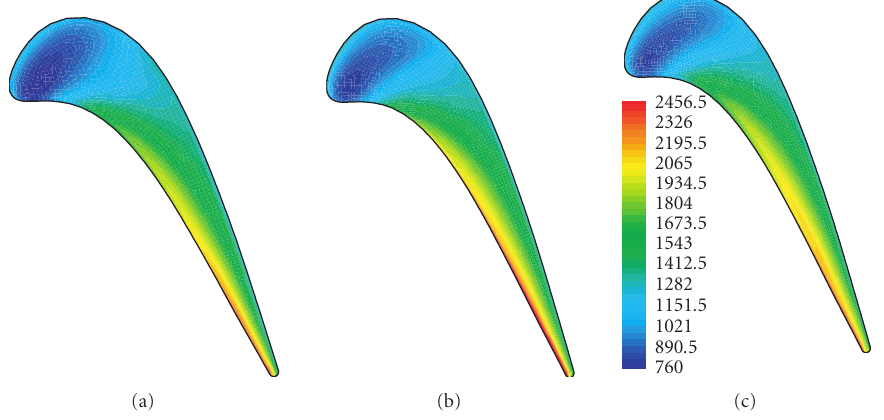
Figure 4: Contours of heat transfer coe ffi cient ( h , W/m 2 -K) at the blade tip for (a) 549556, (b) 803775, and (c) 992282 cells.